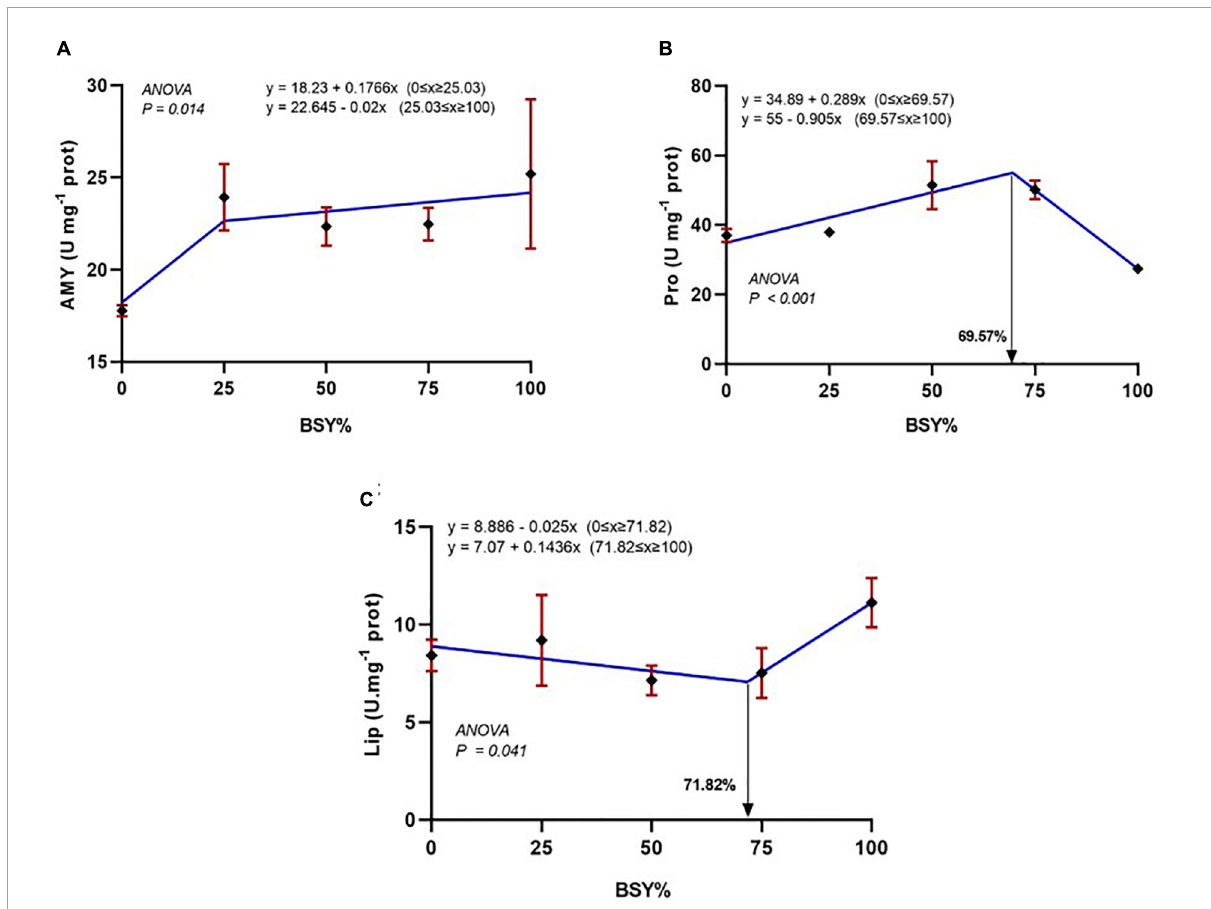
FIGURE7 The responses of digestive enzymes activities of climbing perch fingerlings fed with BSY incorporated diet for 60 days. The X-axis represents the gradient inclusion levels of BSY in the place of fishmeal. (A) Amy, amylase (U mg − 1 of protein); (B) Pro, Protease (U mg − 1 of protein); (C) Lip, Lipase (U mg − 1 of protein), The values are expressed as Mean ± SD, n = 3.